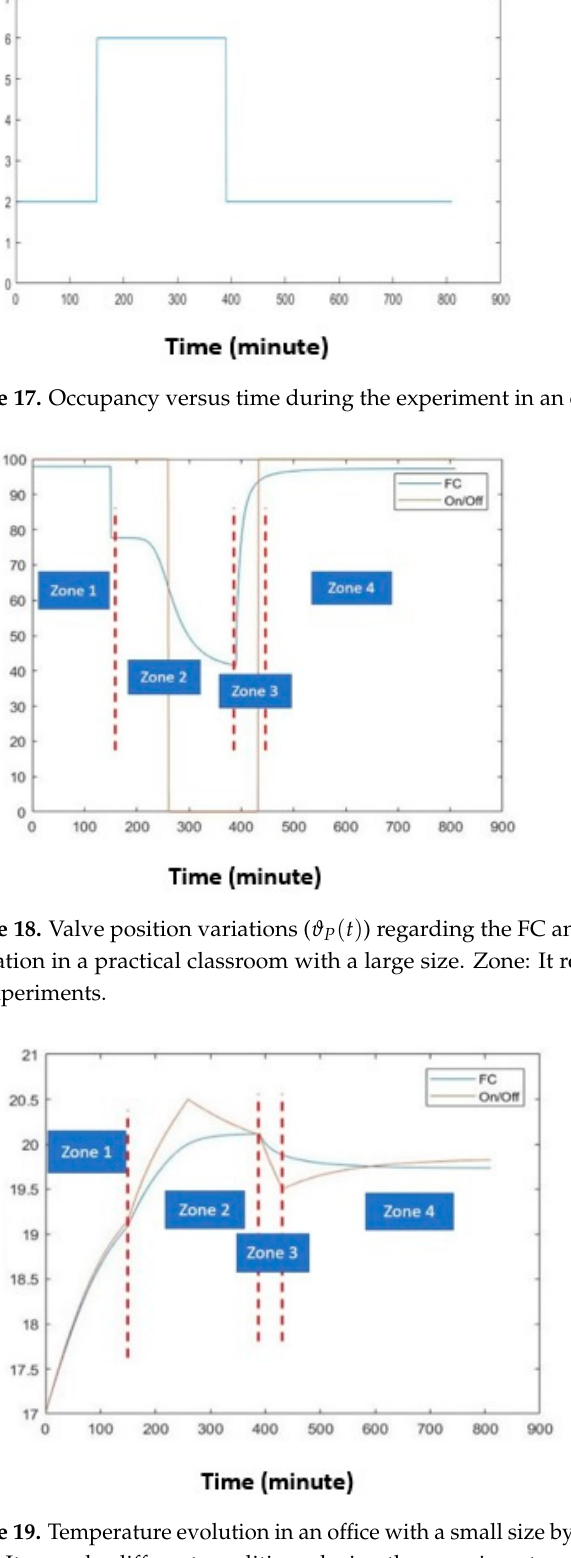
Figure 19. Temperature evolution in an office with a small size by using the FC and On/Off controller. Zone: It remarks different conditions during the experiments.